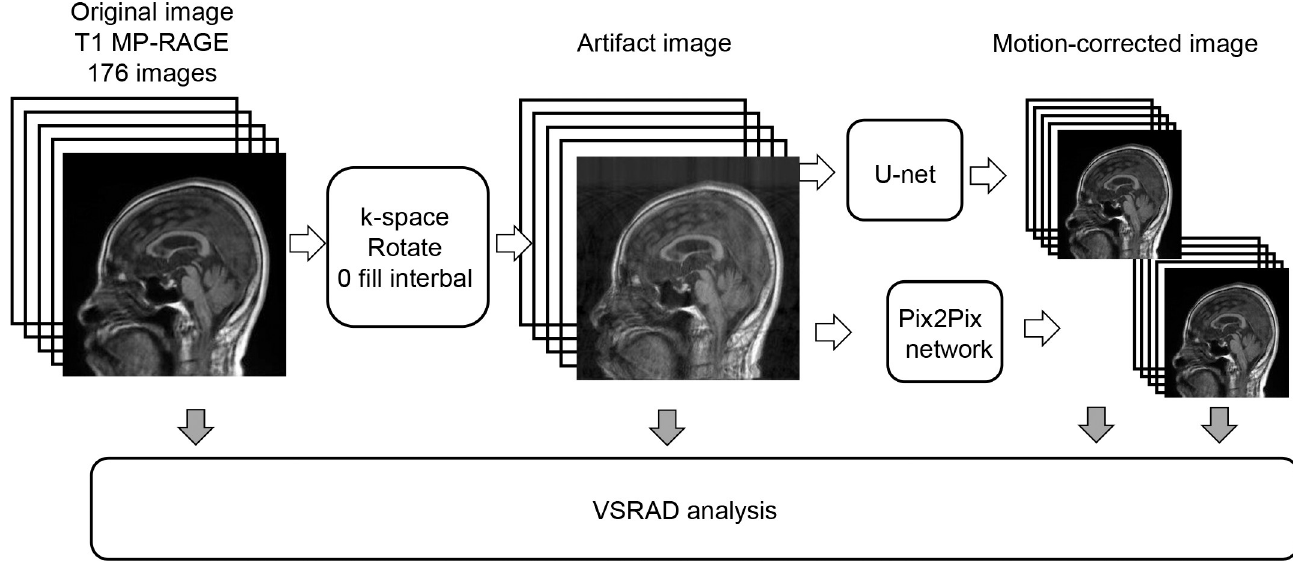
Fig 1. Schematic diagram of this study. Artifact images were created by manipulating the k-space of the original images. Motion artifact suppressed images were generated from the artifact images using the Pix2Pix network. VSRAD analysis was performed on three types of images: the original image, the artifact image, and the motion-corrected image. Then, differences among images of the VSRAD analysis results were